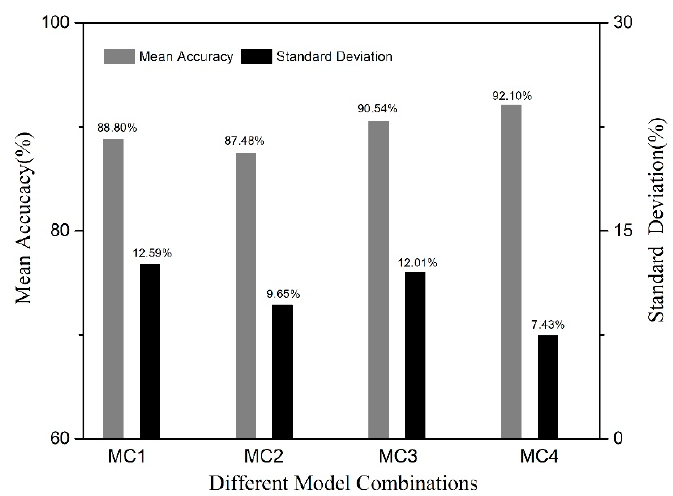
Figure 7. Classification results among different model combinations.